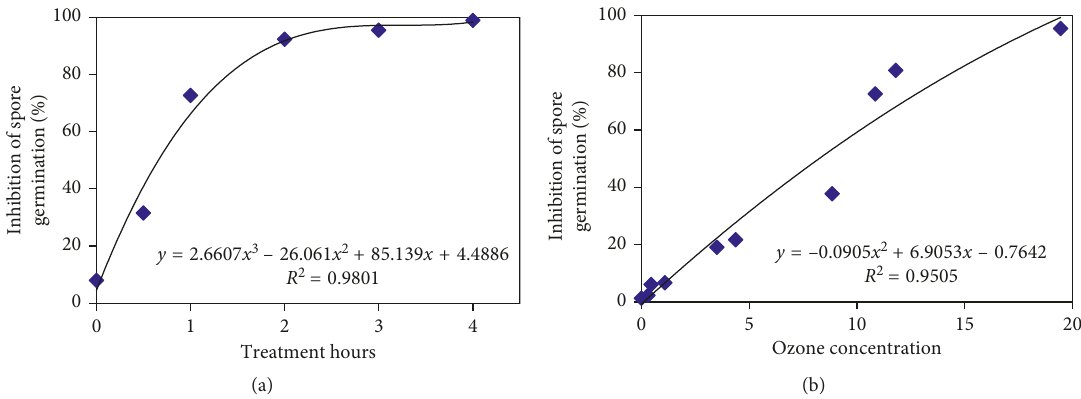
Figure 6: The effect of different plasma treatment time and concentration on the inhibition of germination of Alternaria sp. spore. (a) Plasma treatment of Alternaria sp. spores with different treatment time at constant O 3 concentration (O 3 : 13.7–14.4ppm) and (b) plasma treatment of Alternaria sp. spores with different O 3 concentrations at constant treatment time (2